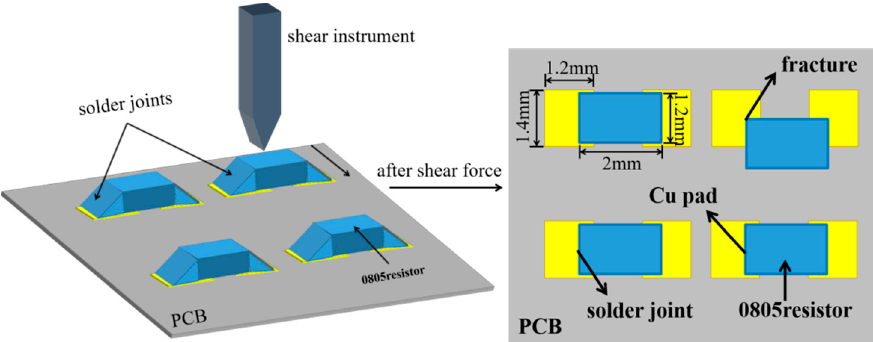
Figure 4. The diagram of shear test.